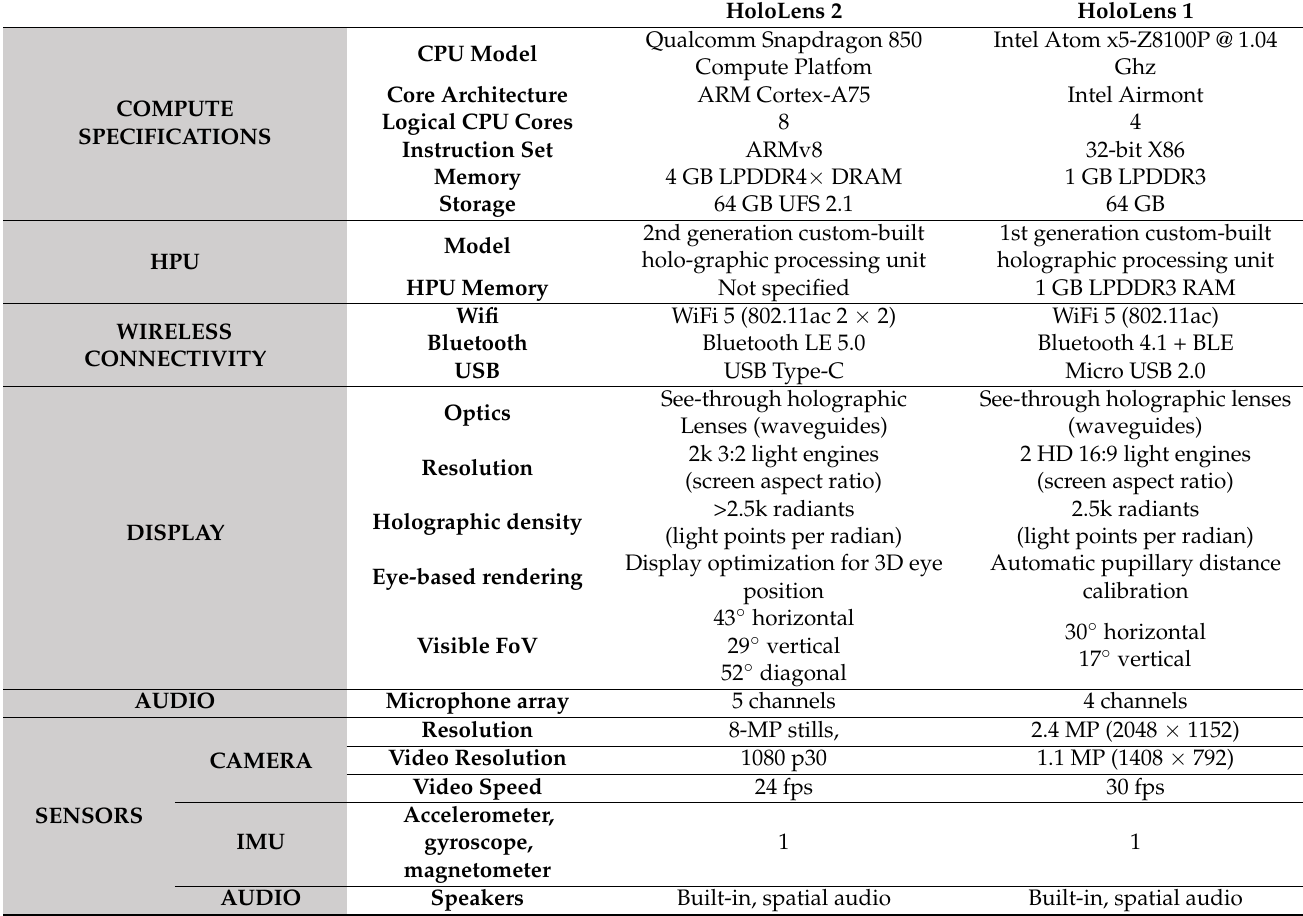
Table 3. HoloLens 2 specifications compared to the first-generation